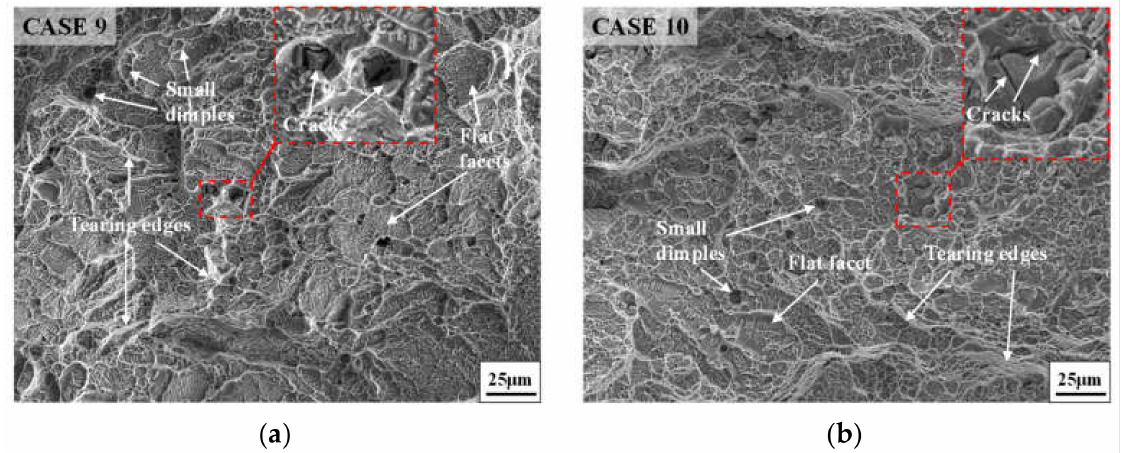
Figure 8. Fracture morphologies of annealed samples at room temperature tensile: ( a ) case 9; ( b ) case 10.